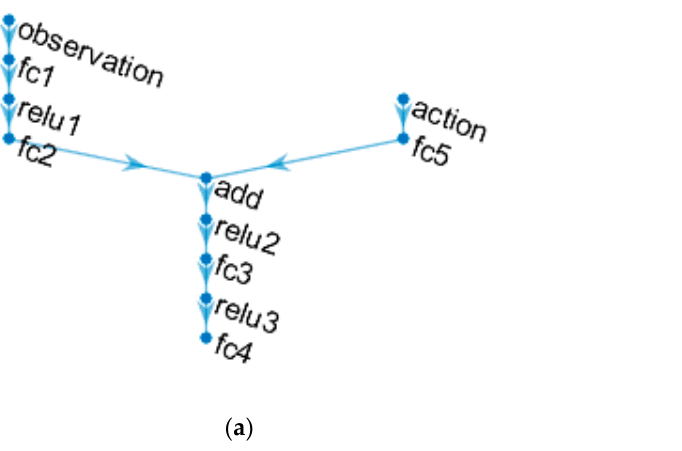
Figure 7. ( a ) Proposed Critic neural network; ( b ) Proposed Actor neural network. Table 1. Characteristics of the critic neural network.